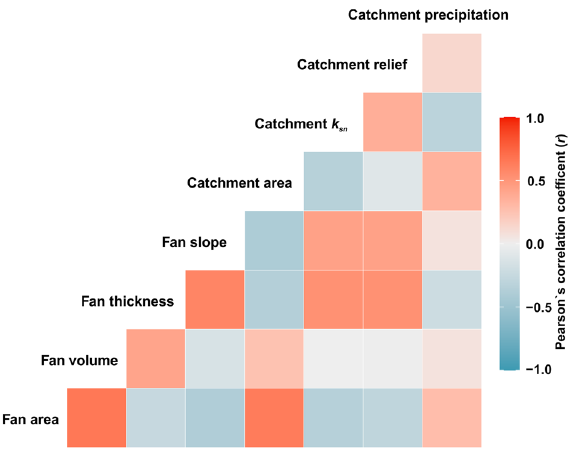
Figure 2. Pearson’s correlation coefficient ( r ) of the eight alluvial fan-catchment